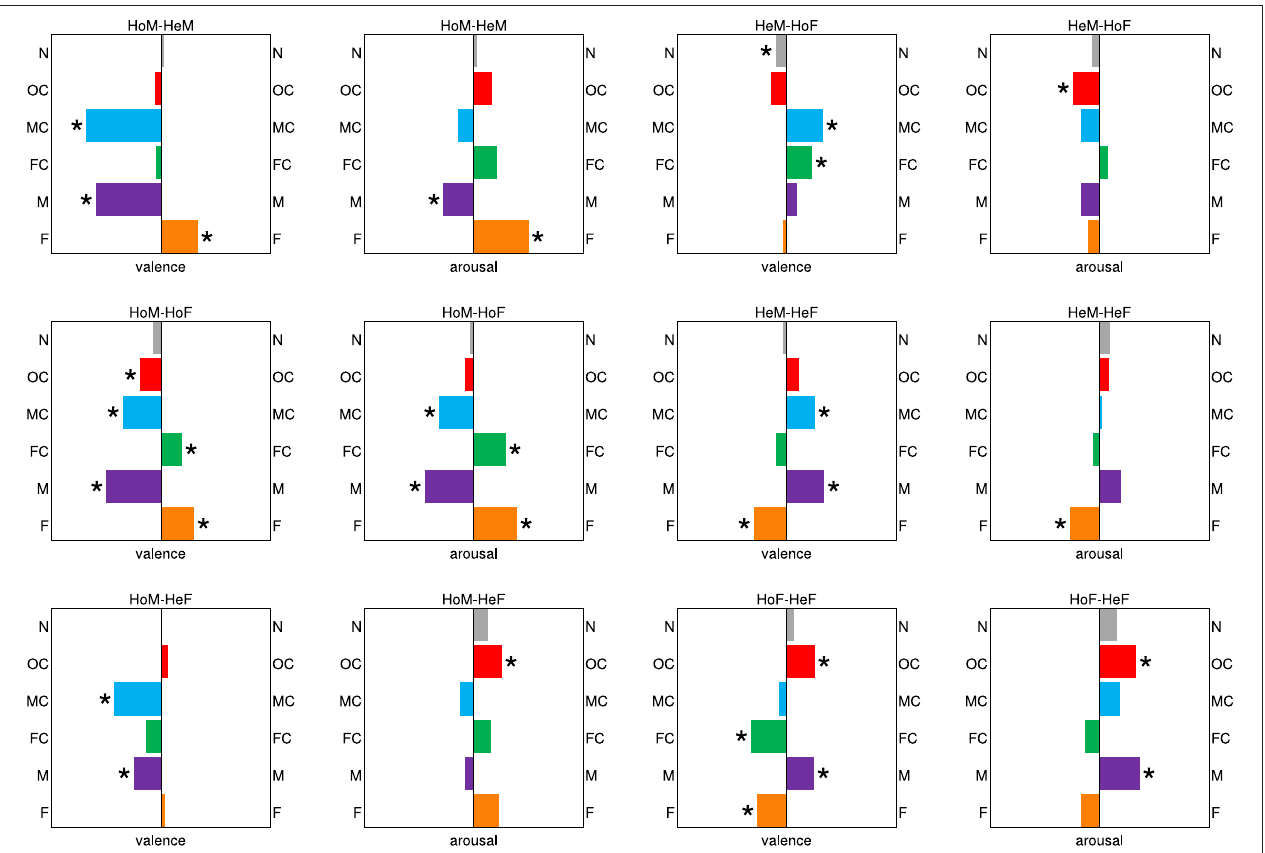
FIGURE 3 | Pairwise comparisons of image ratings averaged over all subjects in a given group and over all images in a given category. Each comparison is done separately for valence and arousal. Significant differences ( p < 0 .05) are marked with an asterisk. Notation: HoM, homosexual males; HoF, homosexual females; HeM, heterosexual males; HeF, heterosexual females; N, Non-erotic; OC, Opposite-sex Couple; MC, Male Couple; FC, Female Couple; M, Male; F,